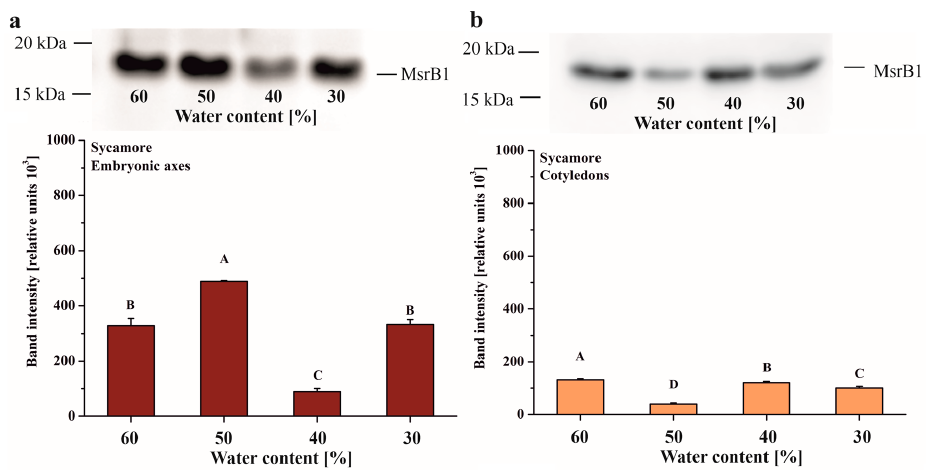
Figure 3. Immunoblot analyses and densitometric analysis of MsrB1 protein in the embryonic axes ( a ) and cotyledons ( b ) of sycamore. The data are the means of three independent replicates ± the STDs. The same letters indicate groups that are not significantly different according to Tukey’s test.